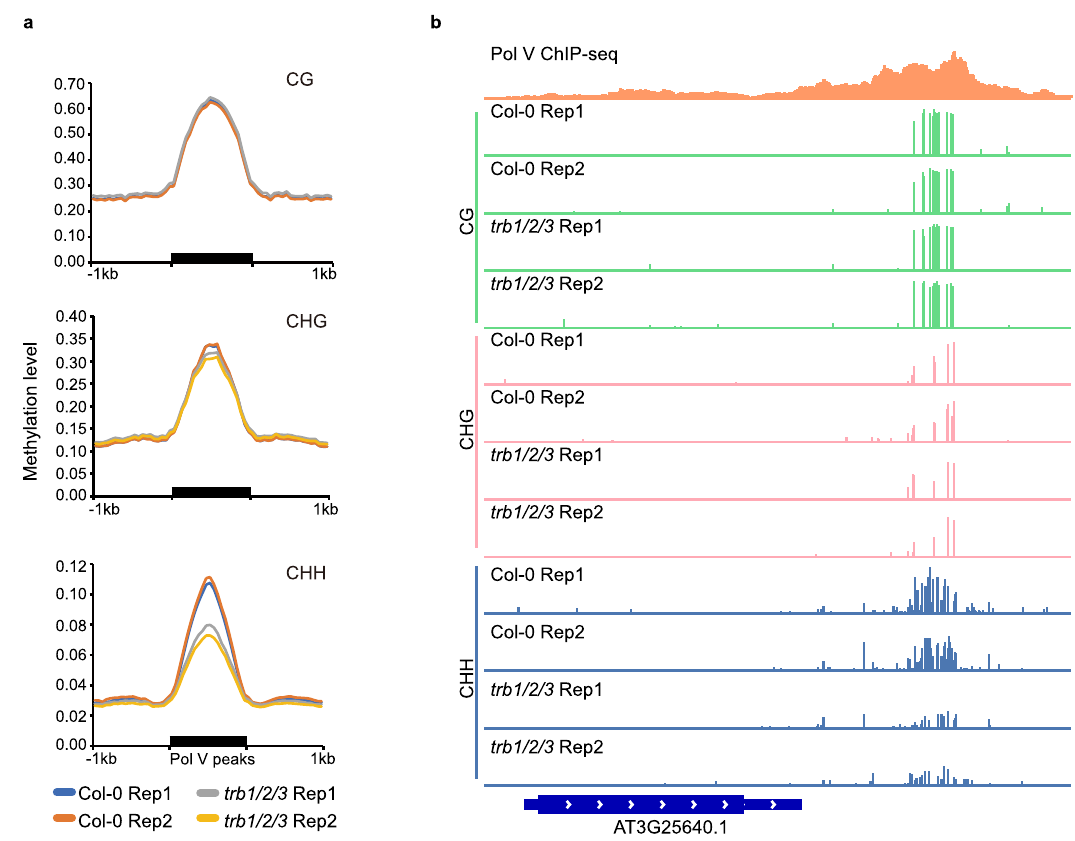
Fig. 5 | Non-CG DNA methylation is reduced in the trb1/2/3 mutant over RdDM sites. a CG, CHG, and CHH DNA methylation level in two replicates of Col-0 and trb1/2/3 triple mutants over RdDM sites, measured by whole genome bisul fi te